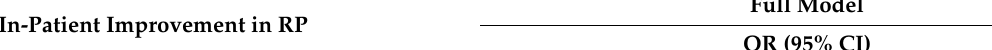
Table 7. Multilevel full model to determine the strength of the association between predictors and improvement in referred pain (RP) ( n =